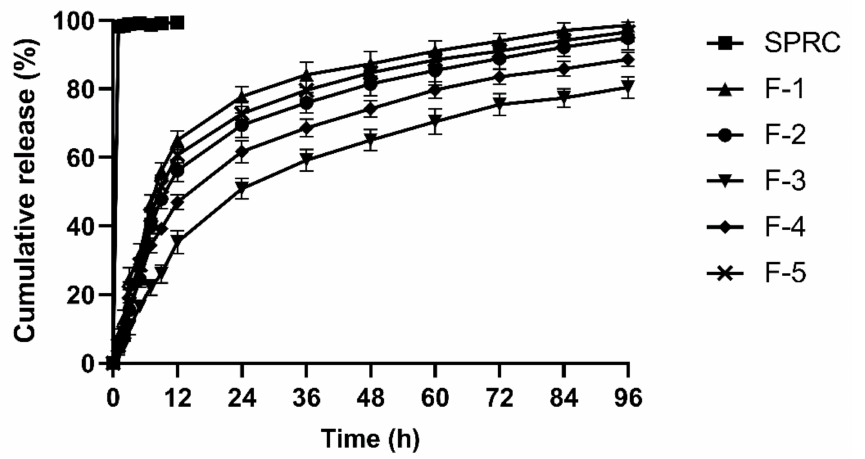
Figure 3. The in vitro release of SPRC from SPRC@PLA in PBS ( n = 3, mean ±